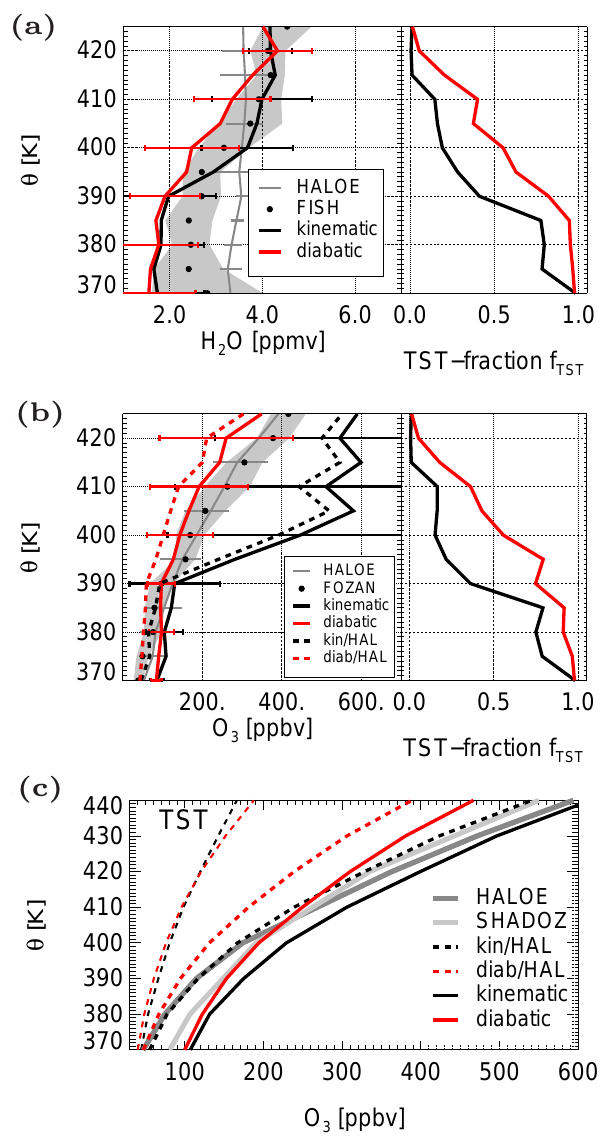
Fig. 3. Mean water vapour (a) and ozone (b) profiles during the SCOUT-O3 campaign, in 5K potential temperature bins. In-situ observations are from the FISH (water vapour, black dots; grey range 1-standard deviation) and FOZAN (ozone, black dots, grey range 1-standard deviation) instruments. Grey solid lines (bars show 1-standard deviation) are HALOE water vapour and ozone measurements during the SCOUT-O3 campaign (see text). Model predictions based on kinematic (black) and diabatic (red) trajecto- ries with initialisation based on ERA-Interim are shown as solid, with ozone initialisation based on HALOE as dashed curves. Pan- els on righthandside show TST fractions (criterion 350K potential temperature, see text). (c) Profiles of tropical mean ozone concen- trations from HALOE, SHADOZ and the 4 model calculations as labelled. Thin dashed red/black lines are ozone predictions from the TST ensemble with initialisation from HALOE